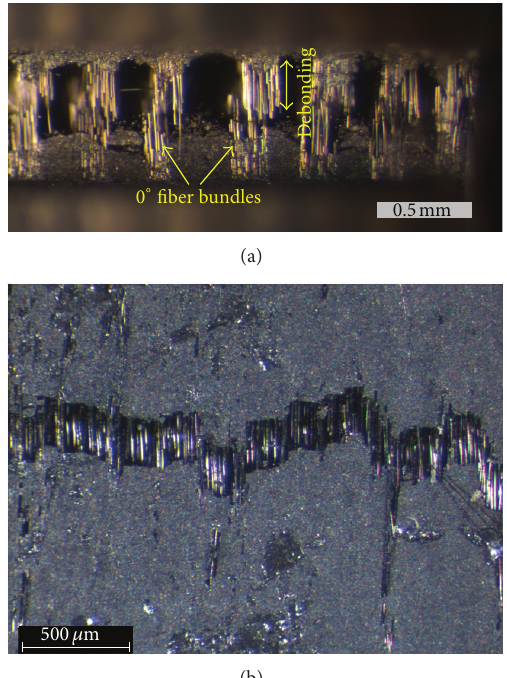
Figure 10: (a) Photograph at the notch of a ruptured specimen. (b) Front view of the crack with continuous fibers bridging the crack